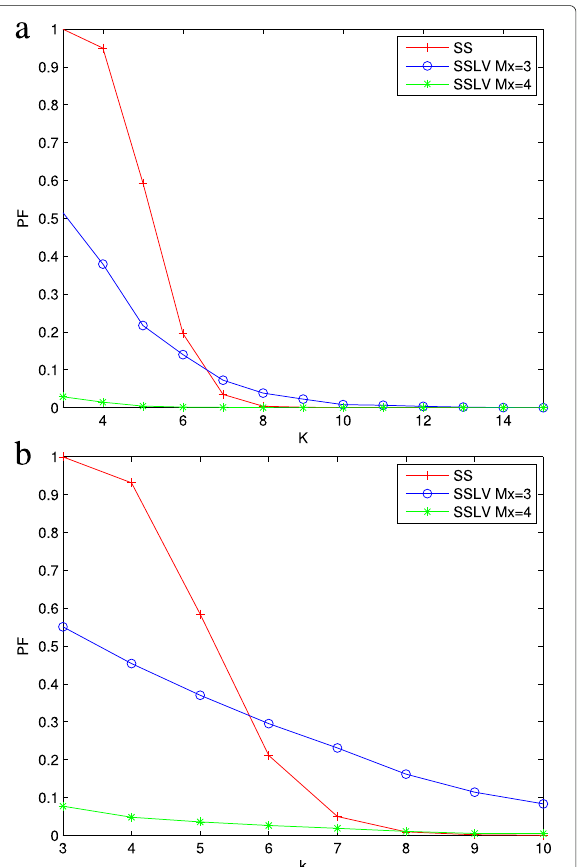
Fig. 5 Probability of detection for MA versus the threshold k . Here, we have N (cid:2) = 27, b = 5, σ 2 = 1, σ w 2 = 4, p f = 0.05, and f ov = 5. Simulations are based on 5000 runs. a Grid deployment. b Random